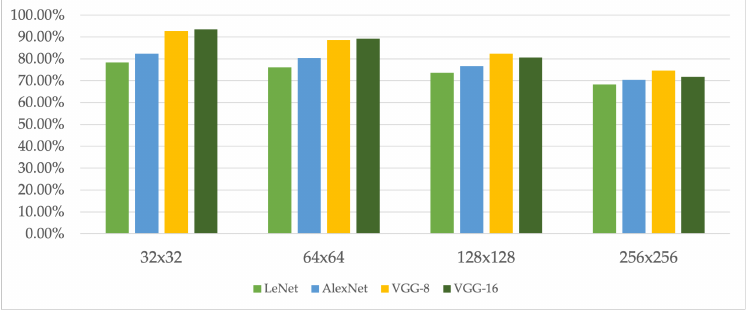
Figure 12. Accuracy of DNN models with different array sizes.